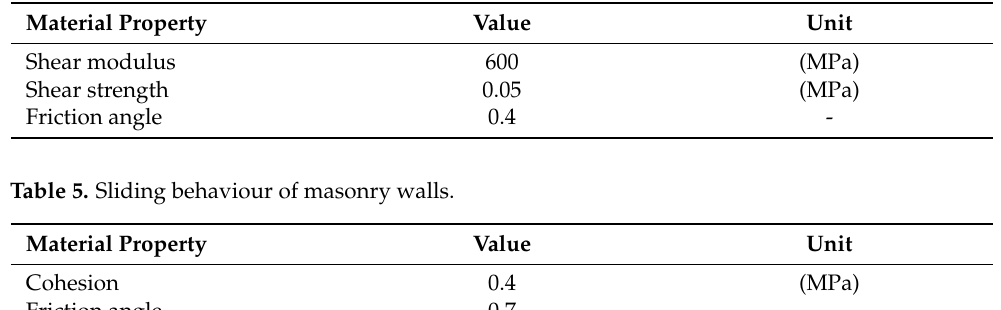
Table 4. Shear behaviour of masonry walls.